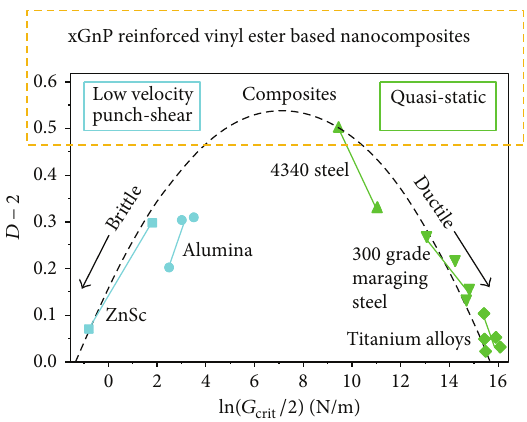
Figure 10: Strain rate dependent ductile-to-brittle transition of fracture propagation mechanism investigated by surface fractal analysis [11, 16,